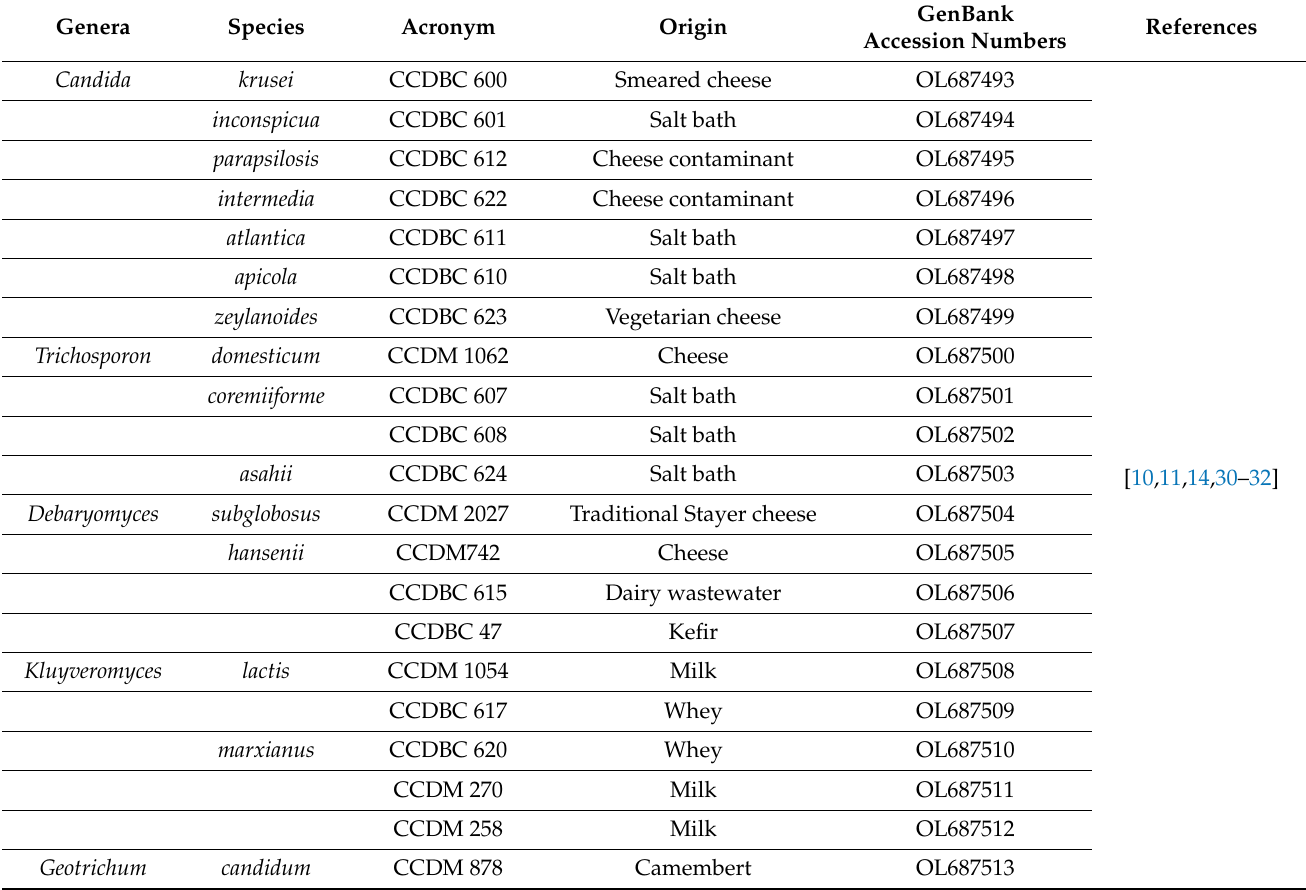
Table 2. The list of spoilage yeasts in dairy products used in experiments including GenBank Accession numbers and the